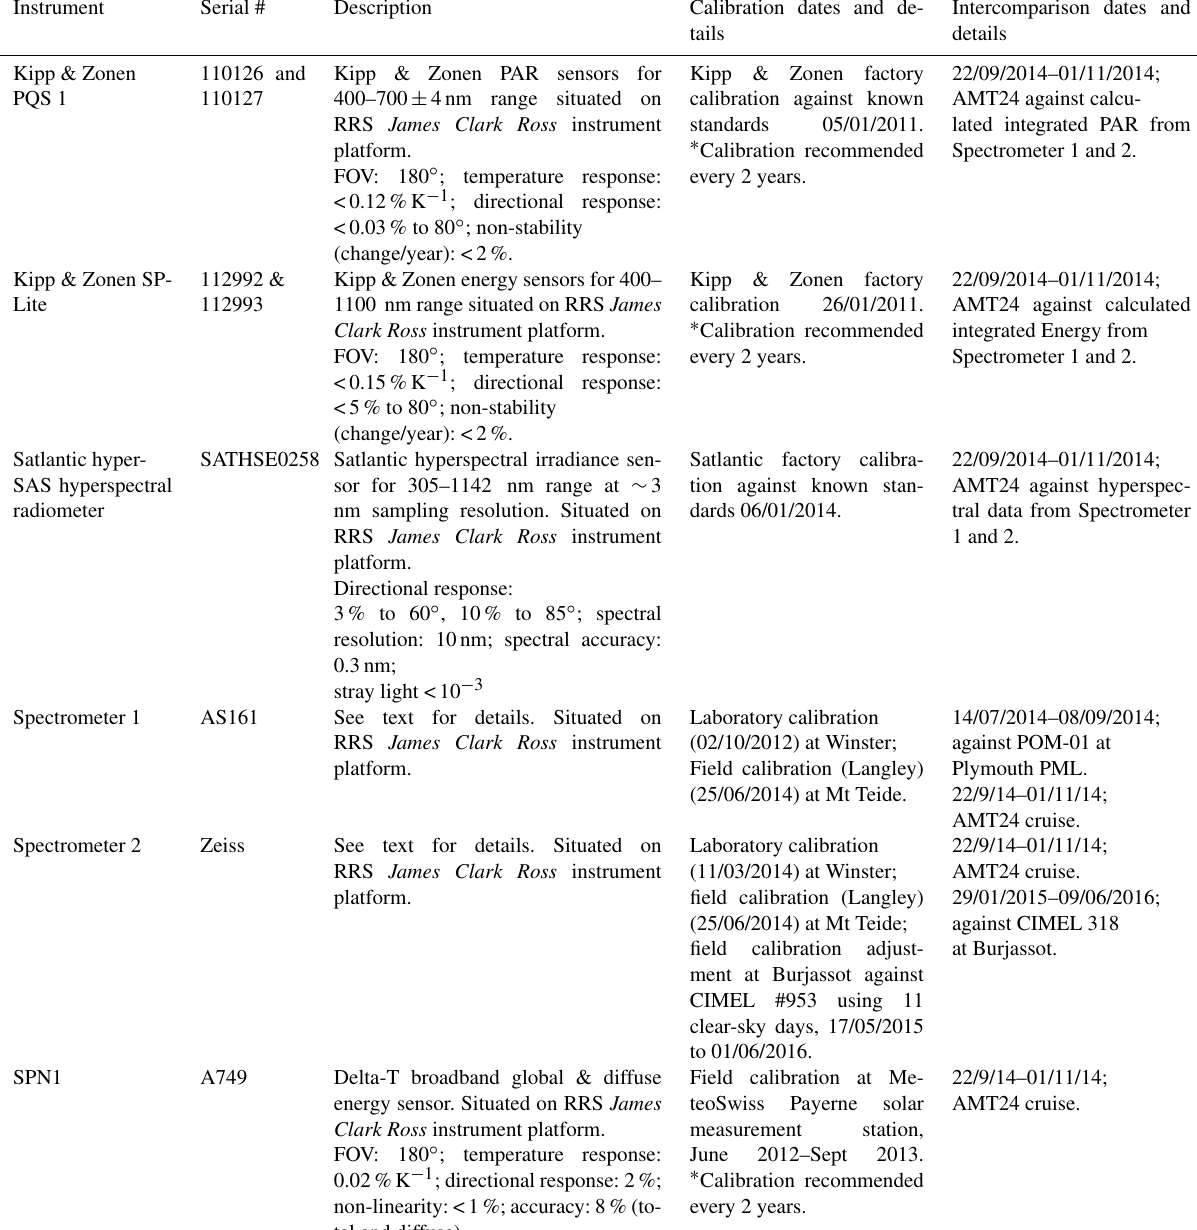
Table 3. Description and calibration details of instruments used in this paper.